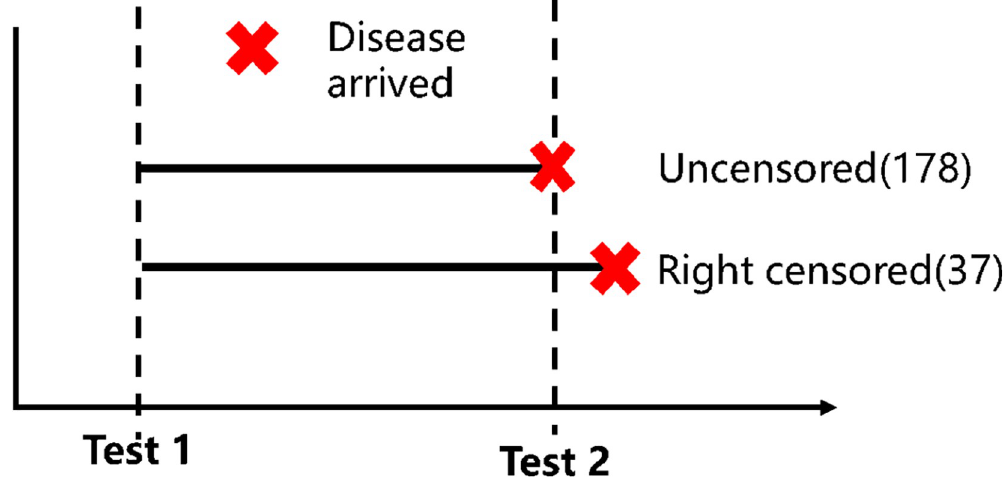
Fig 6. Censored data of COVID-19 arrival